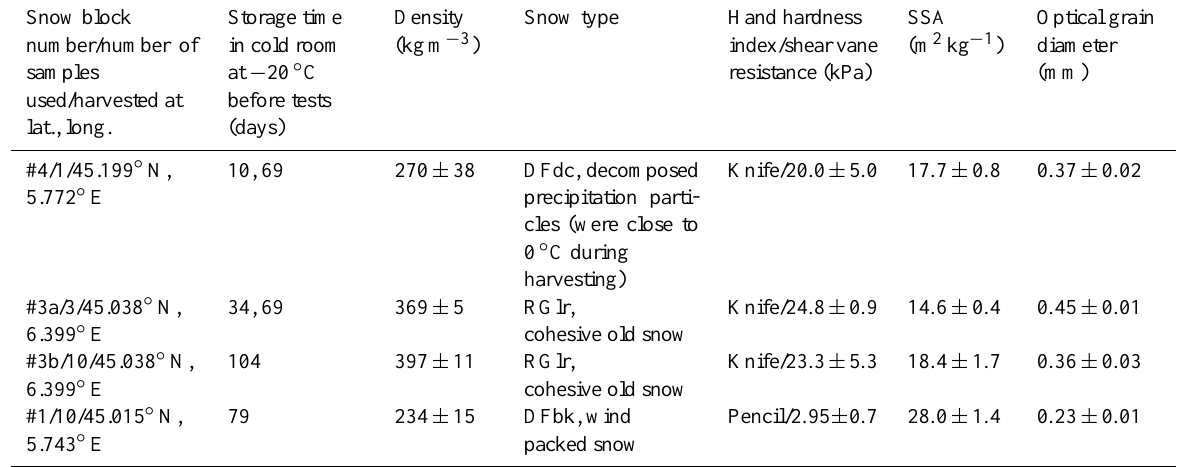
Table 2. Physical properties of tested snow samples. Snow properties are characterized according to Fierz et al. (2009). Errors correspond to standard deviations between measurements. Snow